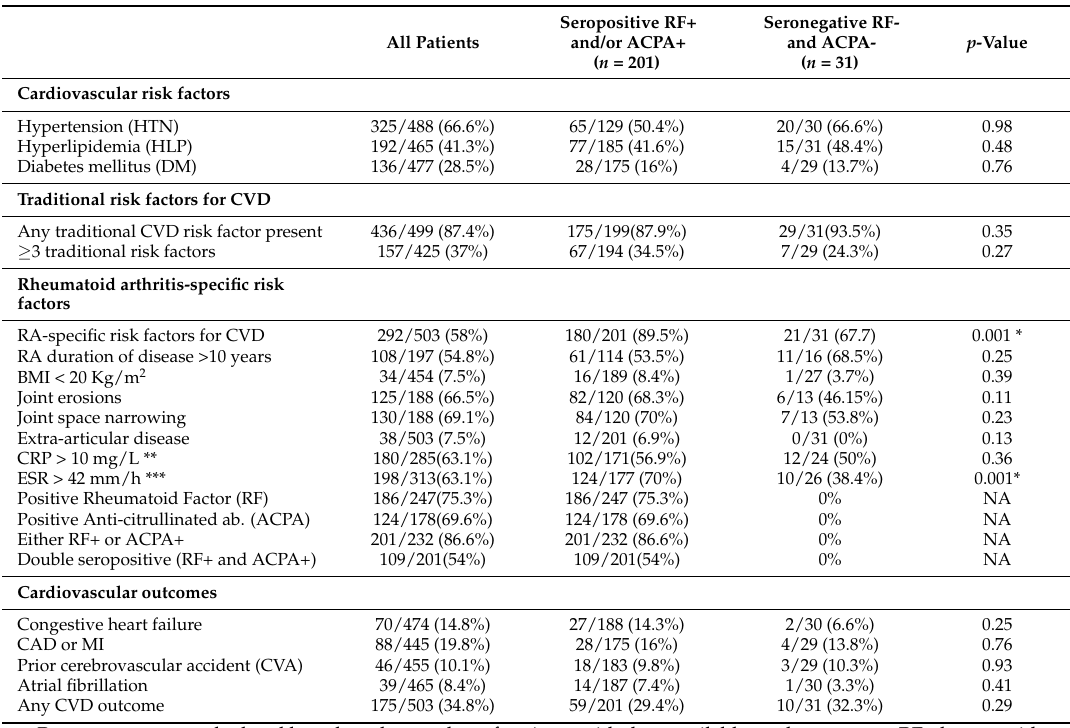
Table 3. Cardiovascular risk factors and outcomes considering the